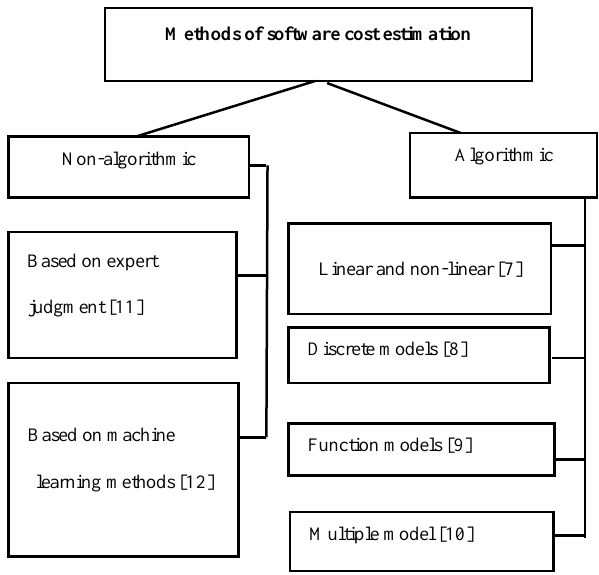
Figure 1. Categorization of cost estimation.